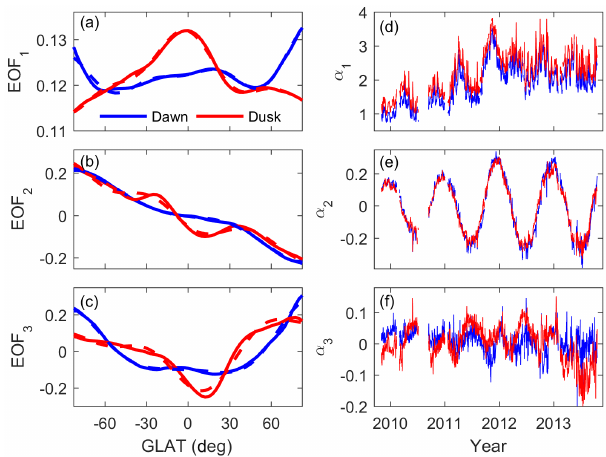
Figure 2. (a, b, c) The first three orders of EOF base functions (solid line) and their fitting results from Eq. (3) (dashed line); (d, e, f) the associated coefficients (10 − 10 kgm − 3 ) of GOCE data at the dawn and dusk LST sectors,